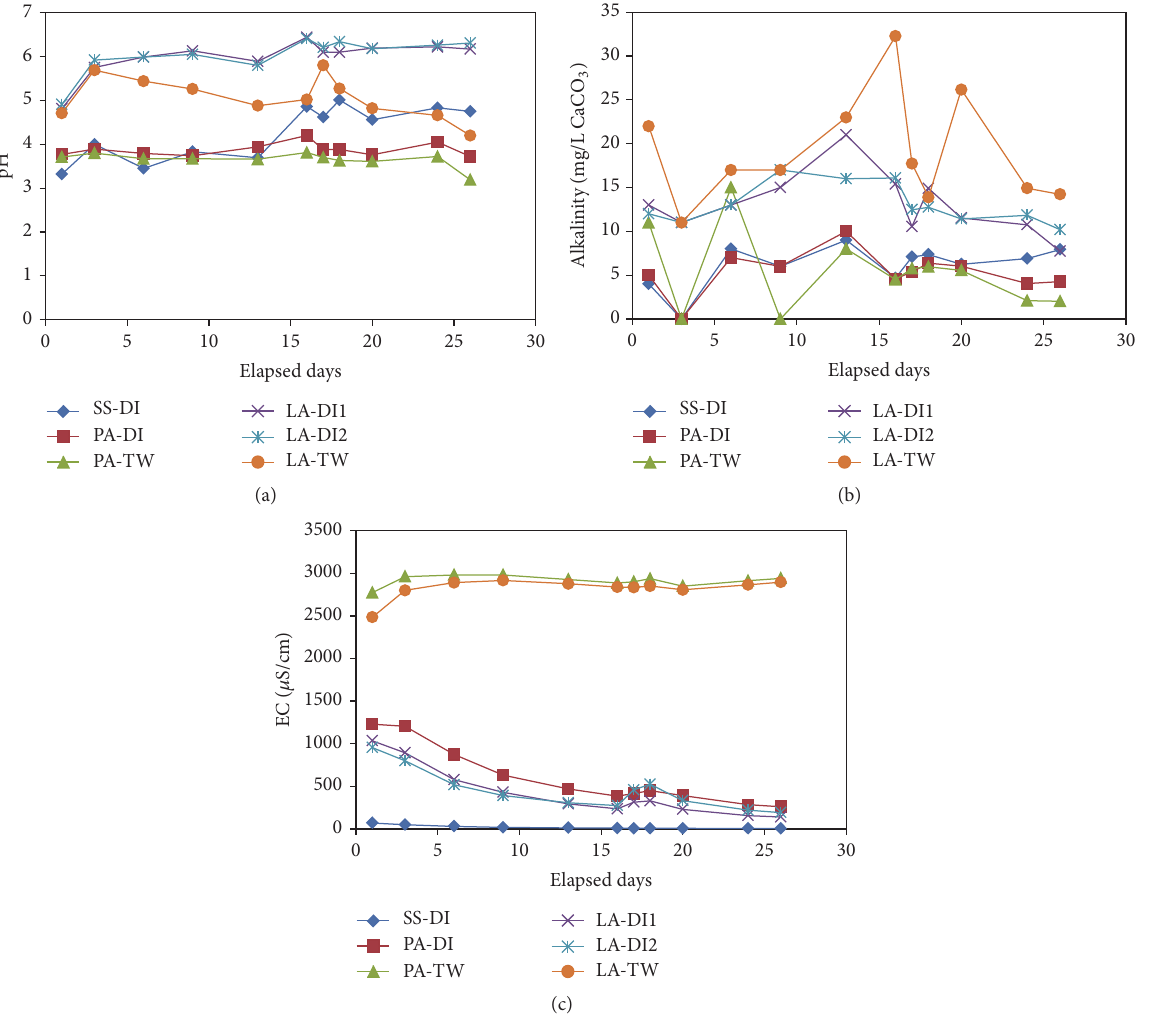
Figure 5: (a) pH, (b) alkalinity, and (c) EC measured over time for each